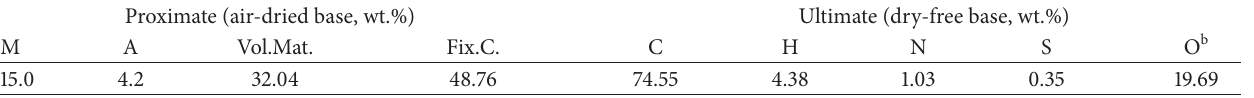
Table 1: Results of Shengli raw